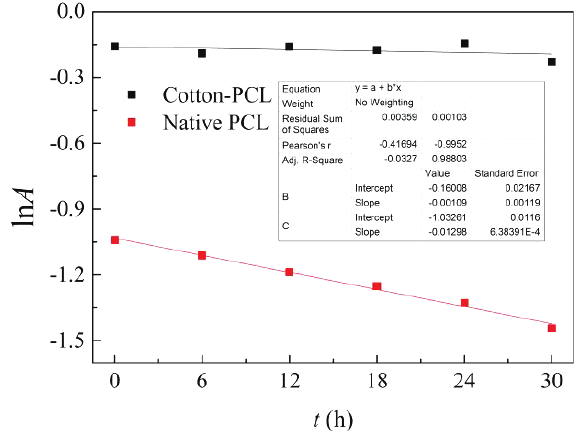
Figure 8: Conversions of transesterifications catalyzed by cotton- PCL and native PCL at 25 or 4°C and in static